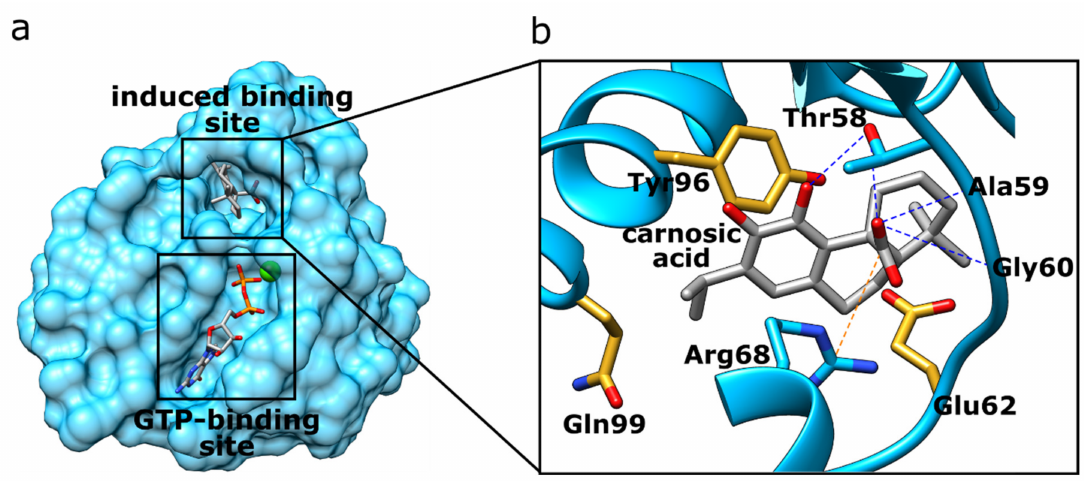
Figure 3. ( a ) K-Ras protein structure highlighting the GTP- and induced-binding site. ( b ) The induced binding site of the K-Ras protein (blue) with docked carnosic acid (carbon atoms depicted in grey). Orange dotted lines represent salt–bridge interactions, and blue dotted lines H-bonding interactions. Amino acid residues forming hydrophobic interactions are denoted with yellow